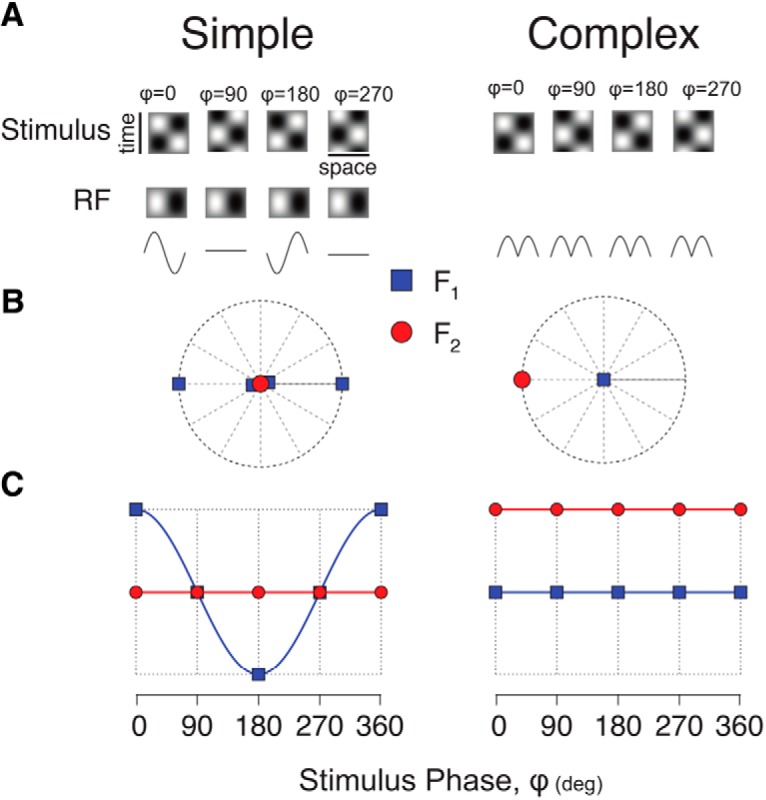
Model responses of a simple and a complex cell to contrast-reversing gratings. A, Simple cell models (left) and complex cell models (right) have distinct responses to contrast reversing gratings. Four different spatial phases of the contrast reversing grating are shown in the top row and the receptive fields of the simple cell are shown below. The receptive field for the complex cell is not shown but reflects the quadrature pairs of simple cell receptive fields (Adelson and Bergen, 1985). Model responses to the contrast reversing grating are shown in the third row. B, Complex plane representation of the responses of the simple cell (left) and complex cell (right) at the first (F1, blue square) and second (F2, red circle) Fourier frequency. C, Amplitudes of the F1 and F2 frequencies projected onto the principle axis (see results).